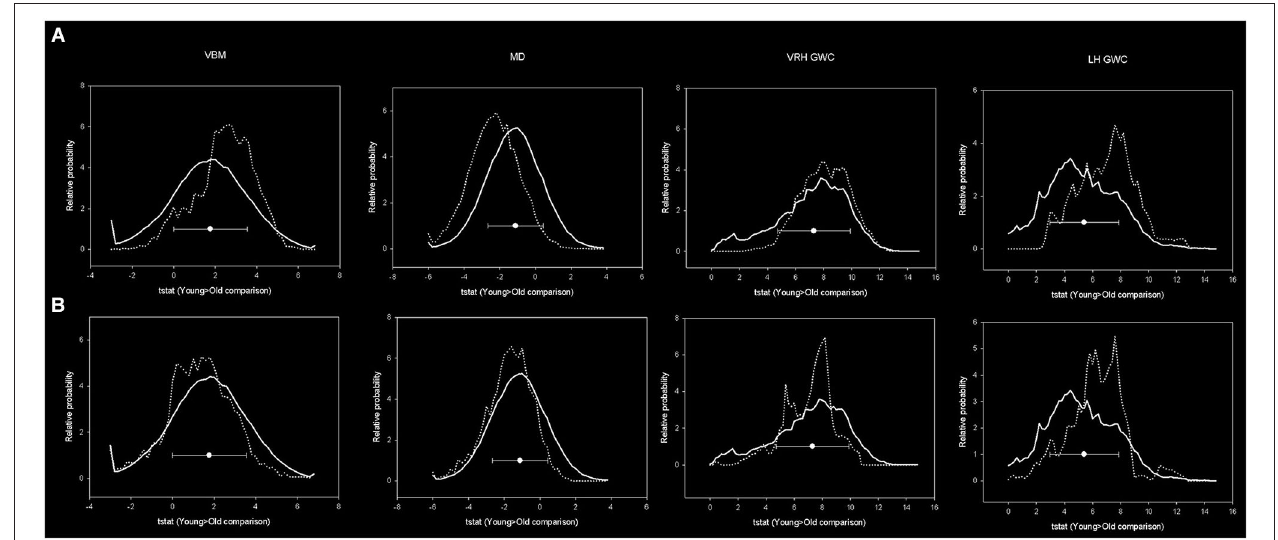
lower images the dotted line represents the age-related distribution within predefined DMN areas. Bins have 0.2 width while the Y axis has been scaled to represent a relative distribution. Circles represent the means and error bars the standard deviations of age-related effects of all brain voxels.